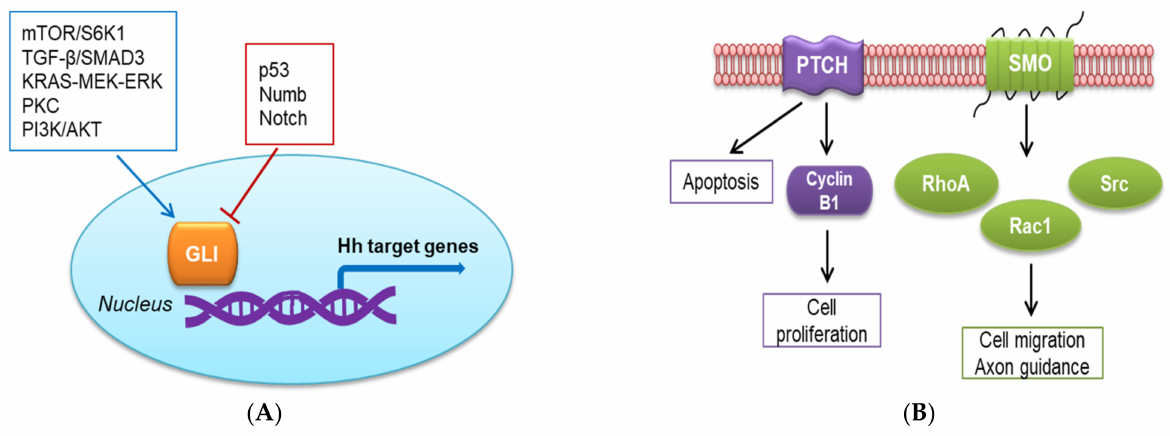
Figure 2. Non-canonical Hedgehog (Hh) signaling pathway. ( A ) SMO-independent GLI activation; ( B ) GLI-independent